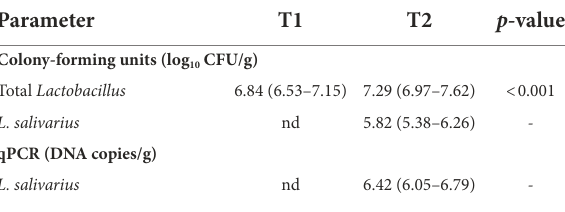
TABLE 2 Microbiological parameters, expressed as mean (95% CI), in the feces of the participants before (T1) and